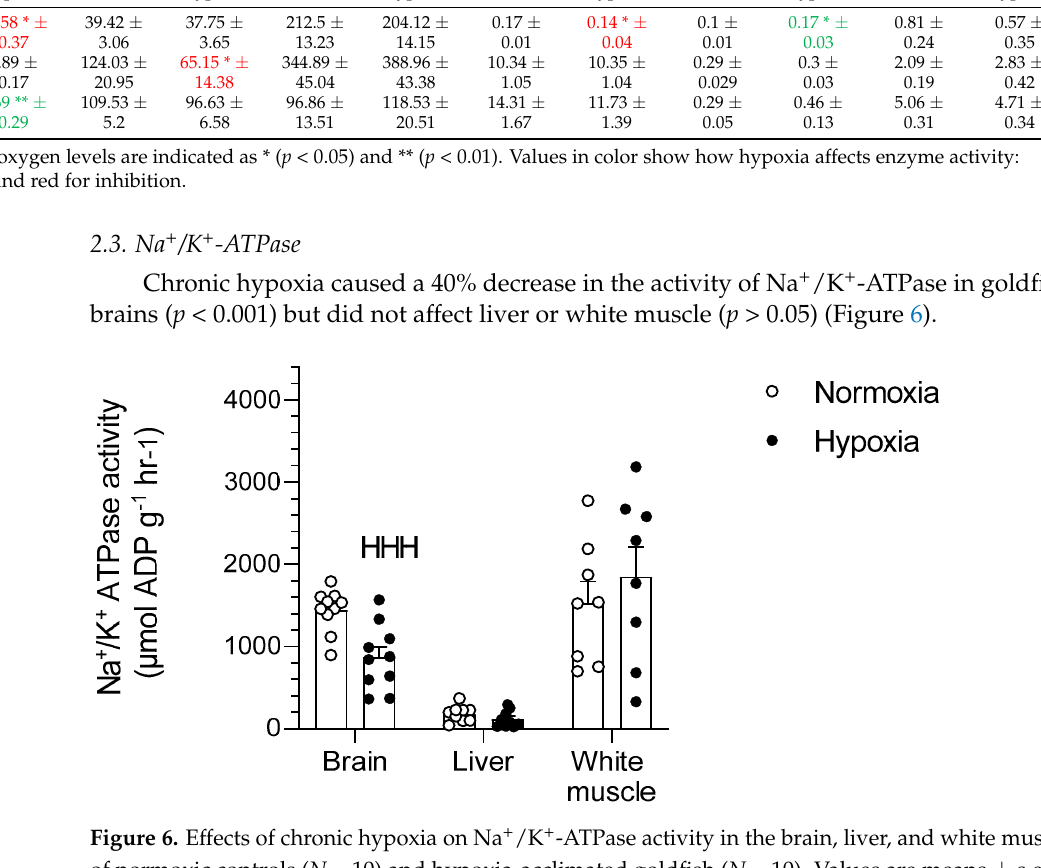
Table 1. Effects of chronic hypoxia on the activities of key enzymes of glycolysis, β -oxidation and tricarboxylic acid (TCA) cycle in goldfish brain, liver, and white muscle ( N = 10 for each treatment group). All values are given in µmol g − 1 min − 1 and presented as means ± s.e.m.